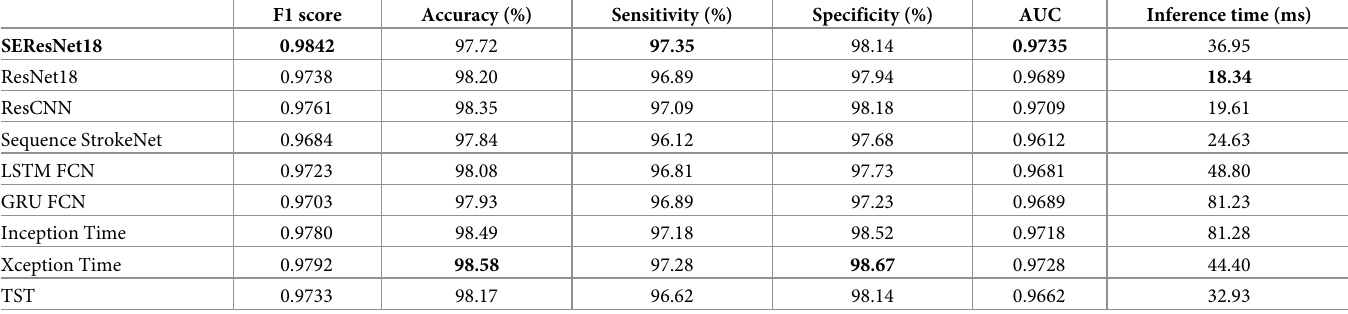
Table 2. Classification results of COVID-19 vs. normal of the different models based on evaluation metrics are F1-score, accuracy, sensitivity, specificity, AUC and inference time.